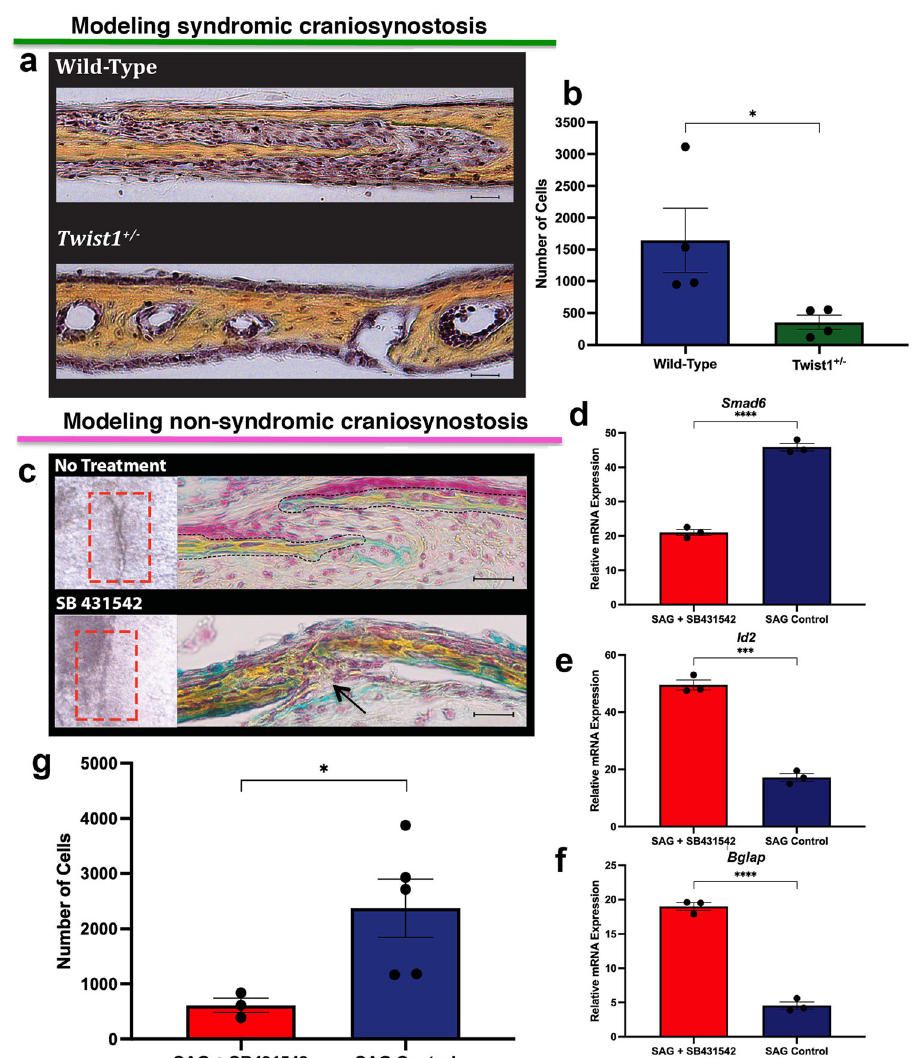
Fig. 3 Imbalance of CD51 + ;CD200 + cells in syndromic and non-syndromic craniosynostosis. a Representative Movat ’ s pentachrome staining showing synostosis of COR suture in day pN15 Twist1 + / − mouse, compared to wild-type suture. Scale bars: 100 μ m. Magni fi cation at ×20. n = 3 animals/group, experiments were repeated 3 independent times. b FACS pro fi ling of CD51 + ;CD200 + cells isolated from explanted wild-type and Twist1 + / − COR sutures at day pN3 reveals a signi fi cant decrease of these cells in Twist1 + / − COR sutures in comparison to wild-type. Values are normalized as total CD51 + ;CD200 + cells per 500,000 events. Data are represented as means ± SEM; P = 0.0482, * P ≤ 0.05, unpaired, two-tailed student t -test were performed. n = 10 animals/timepoint, experiments were repeated 4 independent times. c Whole mount top view (left panel) and Movat ’ s pentachrome staining (right panel) of coronal sections of untreated and SB431542-treated SAG suture explants (day pN3) harvested after 8 days in culture. SB431542-treated SAG suture lacks the suture mesenchyme, with bony tissue (black arrow) replacing the suture mesenchyme and fused. Scale bars: 200 μ m. Magni fi cation at ×40. n = 5 animals/group, experiments were repeated 3 independent times. d – f PCR analysis of Smad6 , Id2 , and Bglap expression in SB431542-treated and untreated SAG sutures con fi rming the effectiveness of SB431542 treatment and inhibition of TGF β signaling paralleled by activation of BMP signaling. Values represent mean± SEM; Smad6 ; P = < 0.0001, Id2 ; P = 0.0001, Bglap ; P = < 0.0001, *** P ≤ 0.001, **** P ≤ 0.0001, unpaired, two-tailed student t -test were performed. n = 5 animals/group experiments were repeated 3 independent times. g FACS pro fi ling of CD51 + ;CD200 + cells isolated from day pN3 untreated and treated sutures harvested after 8 days in culture shows a decrease of these cells in SB431542-treated SAG suture explants. Values are normalized as a total CD51 + ; CD200 + cells per 500 , 000 events. Values represent mean± SEM; P = 0.0478, * P ≤ 0.05, unpaired, two-tailed student t -test were performed. n = 20 animals/group, experiments were repeated 3 independent times. SAG sagittal, COR coronal. Source data are provided as a Source data fi